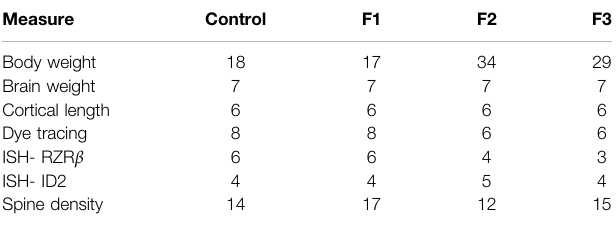
TABLE 1 | Number of animals (n) in each experimental condition: behavior. Measure